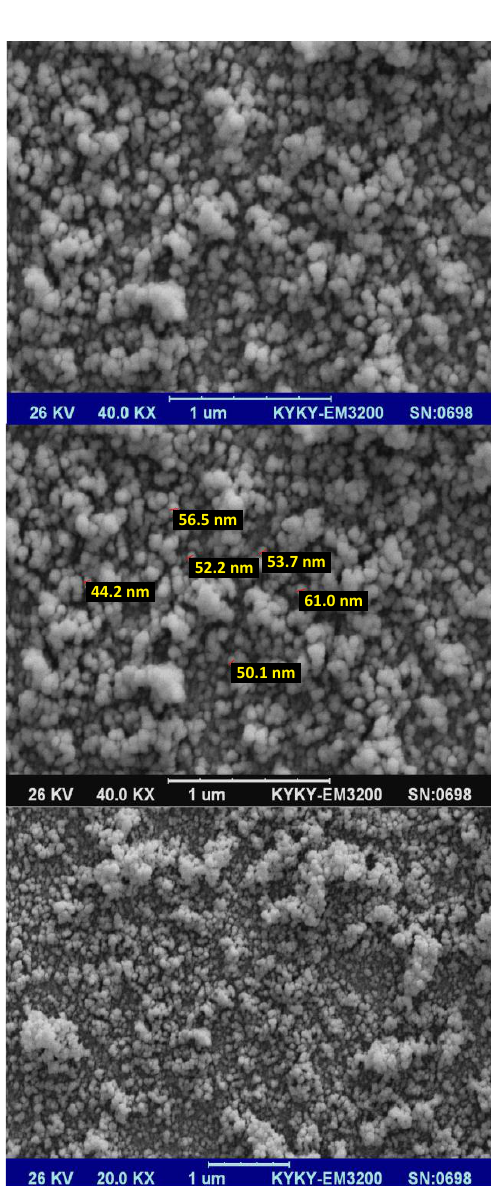
O nanoparticles obtained at 2 4 300W.